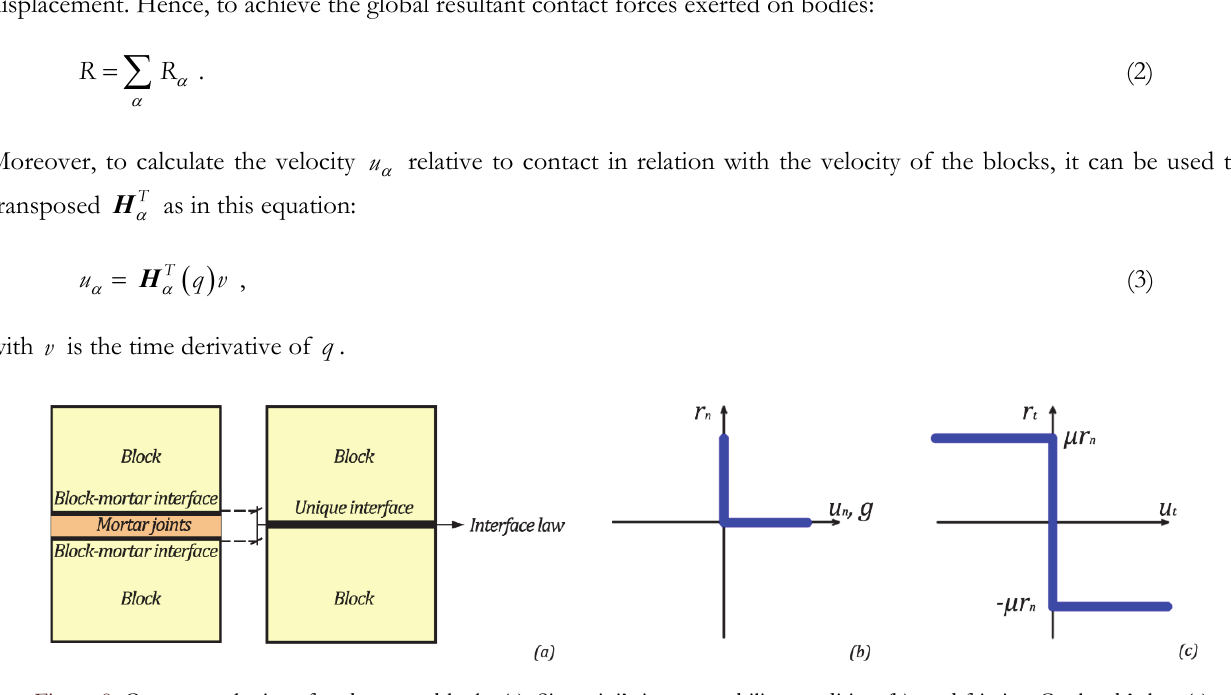
Figure 8: Contact at the interface between blocks (a), Signorini’s impenetrability condition (b), and friction Coulomb’s law